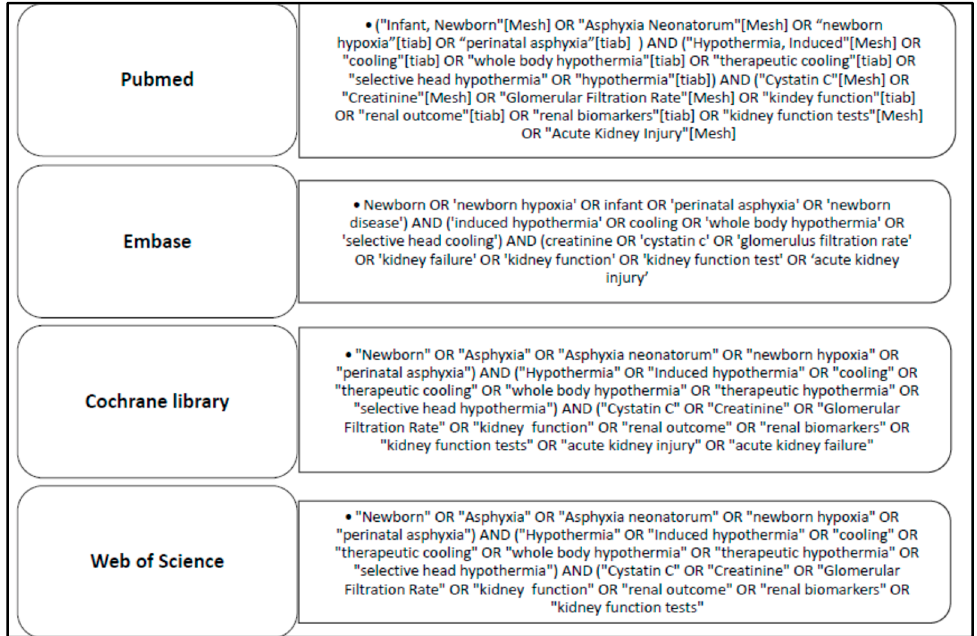
Figure 1. Search strategy as conducted on PubMed, Embase, Cochrane Library, and Web of Science .